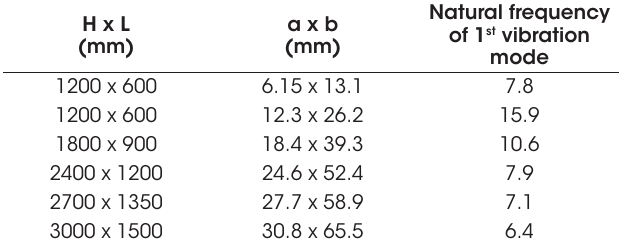
Natural frequencies for the first mode of vibration of the various frames tested by the